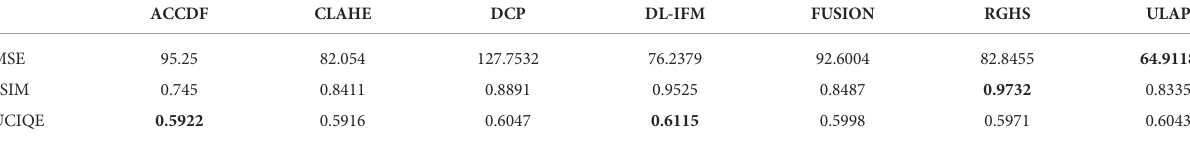
TABLE 3 Quality evaluation of Figure 14C .